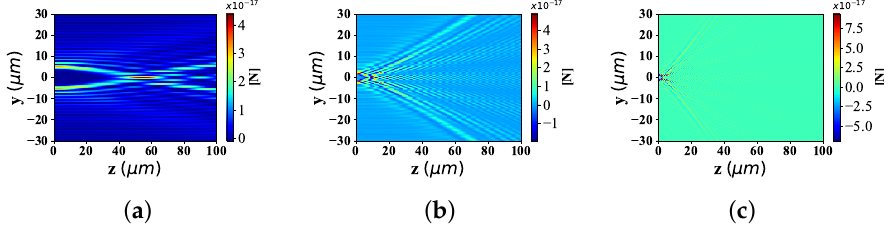
Figure 7. Distribution of F z under the interaction between the sphere and Bessel pincer light-sheets beam with different beam scaling parameter α 0 ( α 0 = 0.2, 0.5, and 0.8; beam order is l = 10). ( a ) α 0 = 0.2; ( b ) α 0 = 0.5; ( c ) α 0 =